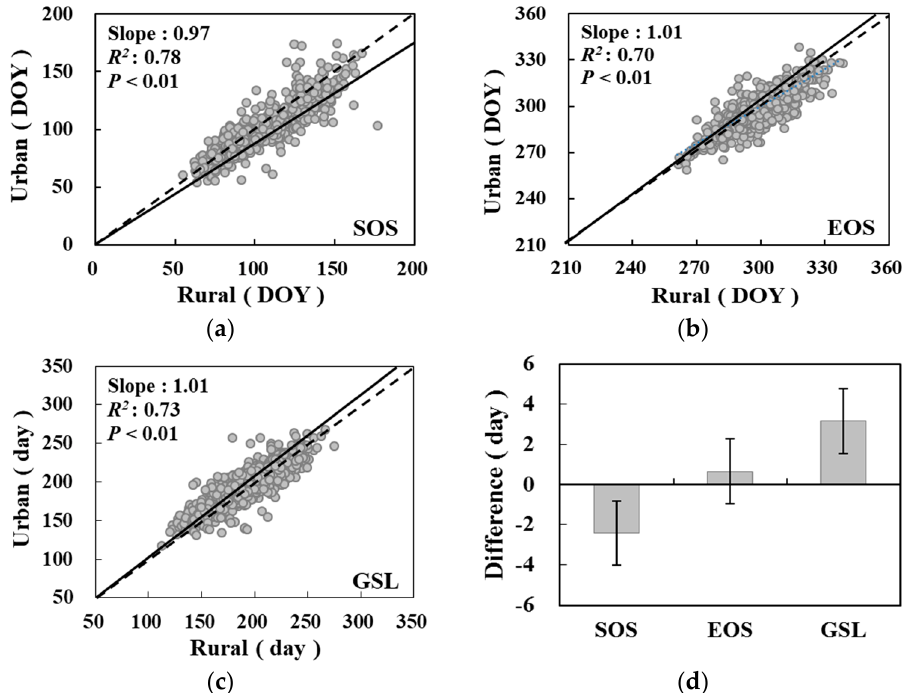
Figure 4. The relationship of vegetation phenology indicators of ( a ) SOS, ( b ) EOS and ( c ) GSL between urban areas and their corresponding rural areas; ( d ) The difference in phenology between the urban and its corresponding rural areas. The error bars represent the standard error. Table 1. The impact of urbanization on vegetation